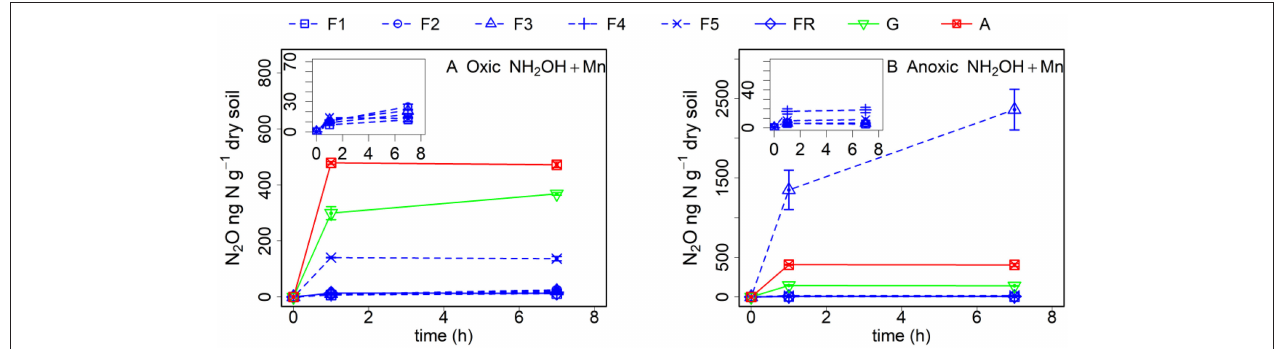
FIGURE 3 | Soil N 2 O production (ng N g − 1 dry soil) after MnO 2 and NH 2 OH addition after oxic (A) and anoxic (B) pre-incubation for samples from forest (F1, F2, F3, F4, F5, and FR), grassland (G) and arable land (A) without γ -irradiation. The values are presented as mean ± standard deviation (SD, n = 3).